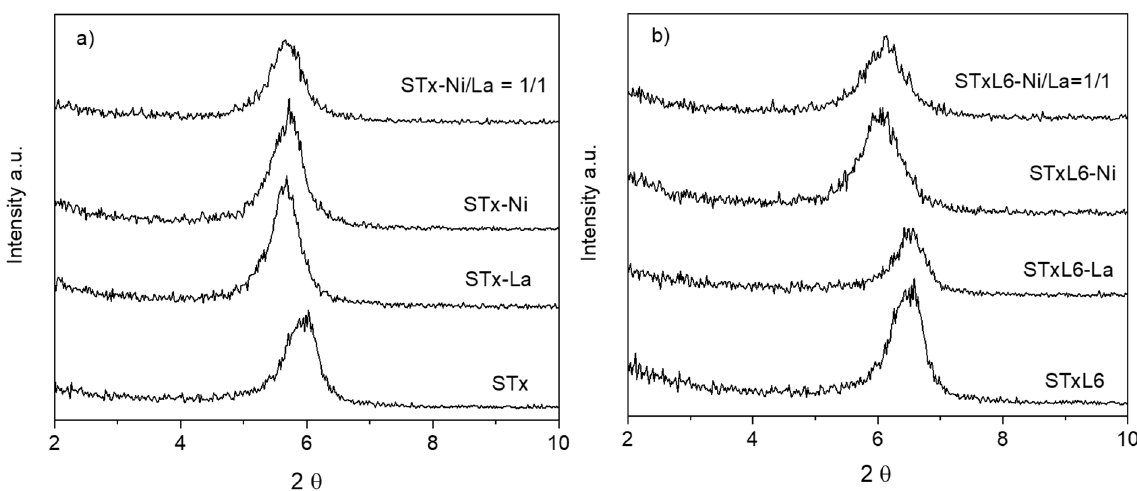
Figure 4. XRD patterns of the sorbent solids after the capture of La and Ni in single ion and mixed Ni/La solutions: ( a ) pristine STx and ( b ) modified STxL6 (STx and STxL6 are reported for comparison).